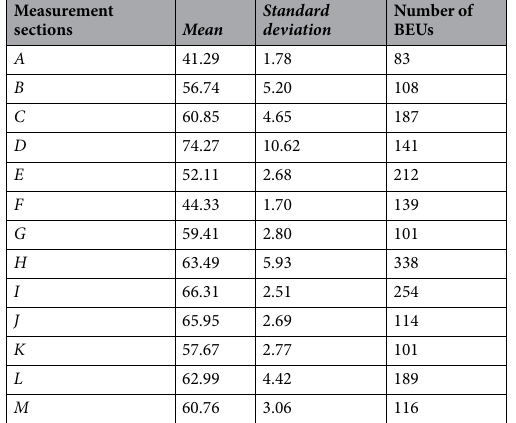
Table 5. The Mean, standard deviation of riparian PSI and number of BEUs in each measurement